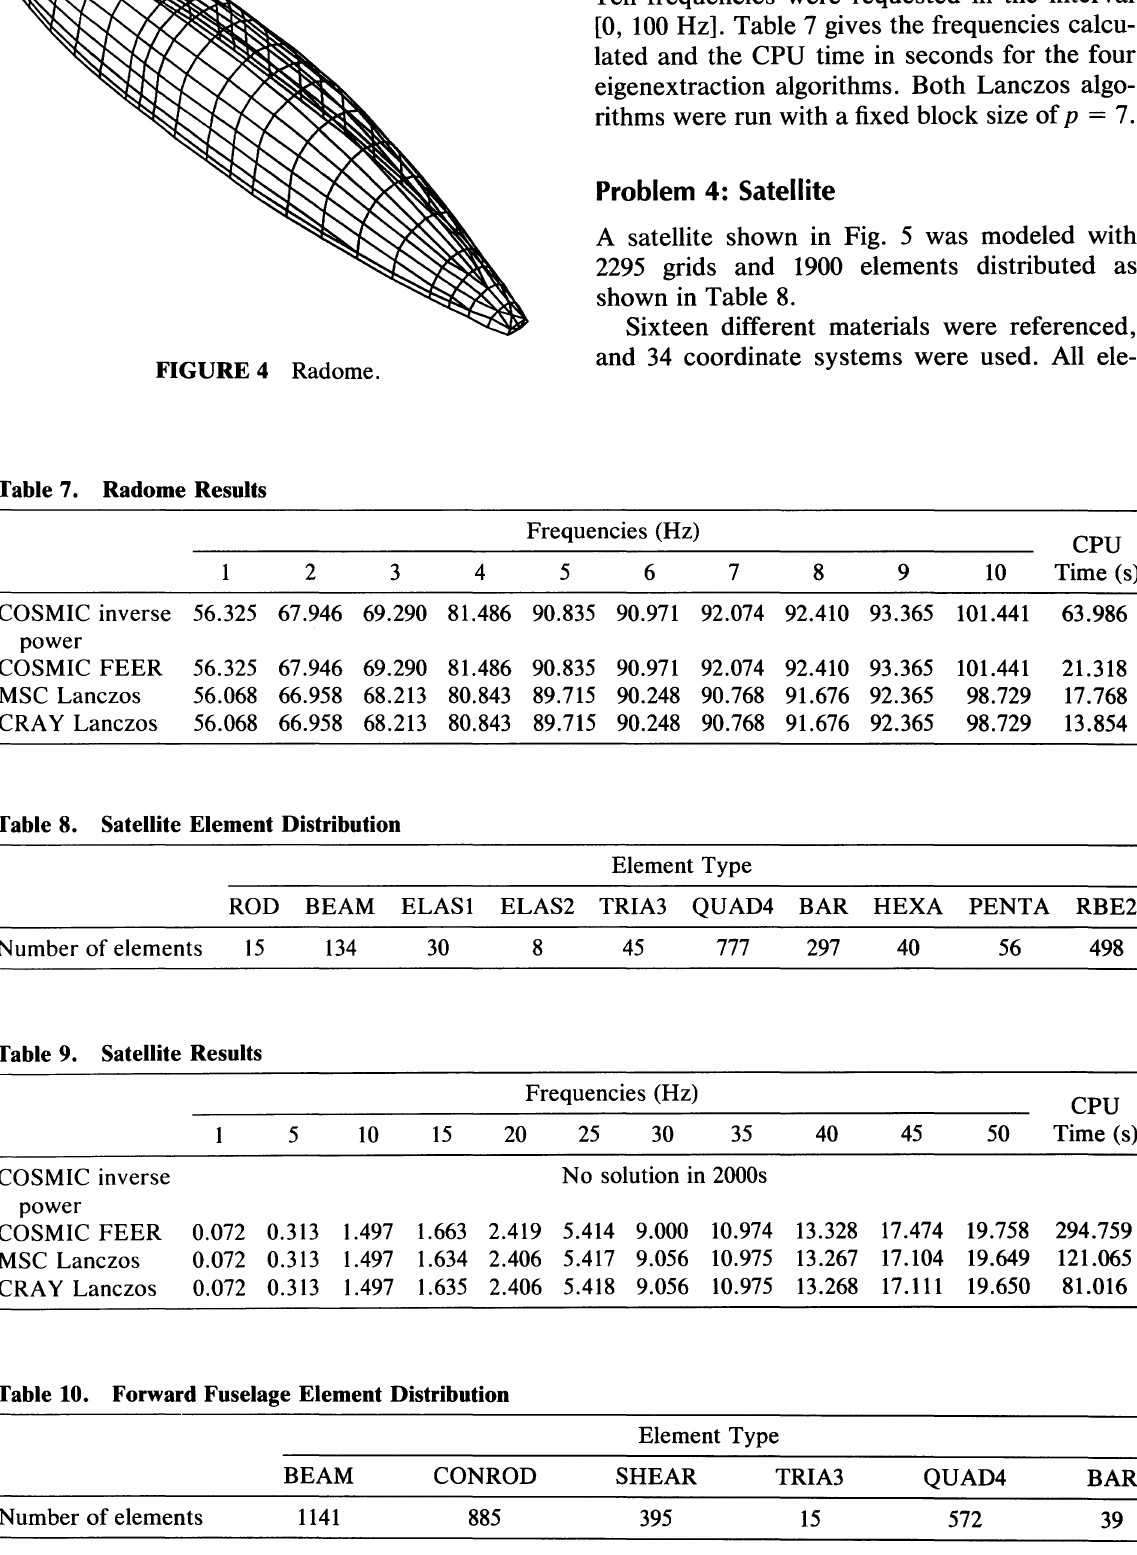
Table 7. Radome Results